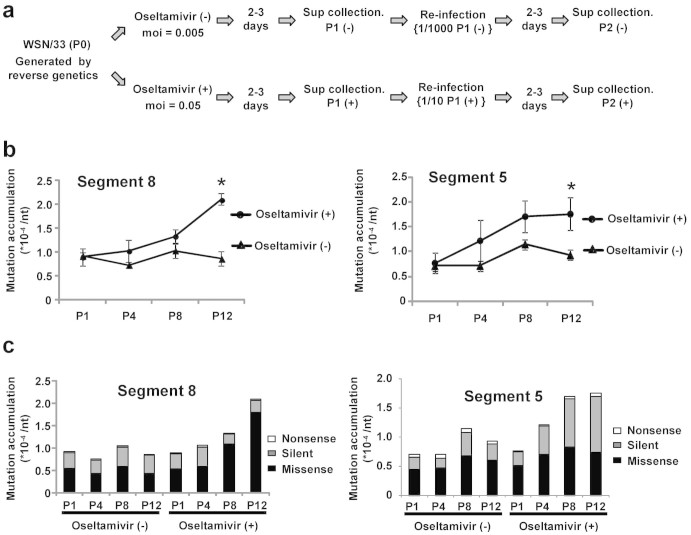
Expansion of virus quasispecies by oseltamivir.(a) Experimental scheme. MDCK cells were infected with wild-type virus at MOI of 0.005 or 0.05 and cultured in the absence or presence of 50 μg/ml of oseltamivir. When CPE was observed, the culture supernatant was collected and designated P1. Viruses grown in the presence of oseltamivir were harvested from the cell surface using bacterial NA. Supernatant P1 obtained in the absence or presence of oseltamivir were diluted 103 times and 10 times, respectively and employed for infection in the second round of passage. After infection, cells were cultured in the absence or presence of 50 μg/ml oseltamivir again. This procedure was repeated 12 times. (b and c) Ratio of mutation accumulated in virus genome. Viral RNA was collected from supernatant P1, P4, P8, and P12, and the cDNA of segment 8 and 5 between the nucleotide positions of 41 to 386 and 217 to 552, respectively were amplified by RT-PCR. After gel purification, cDNAs were subjected to Next-Generation sequencing, and the ratio of mutation accumulated in virus segment was calculated (b). The ratio of the mutation accumulation in P12 virus treated with oseltamivir was compared with that of P12 virus which was not treated. *, P < 0.05. Error bars indicate s.d. from 3 independent experiments. The number of nonsense, silent, and missense mutation in NS1 encoded by segment 8 and NP encoded by segment 5 at the amino acid positions of 13 to 113 and 65 to 162 was counted, respectively (c).